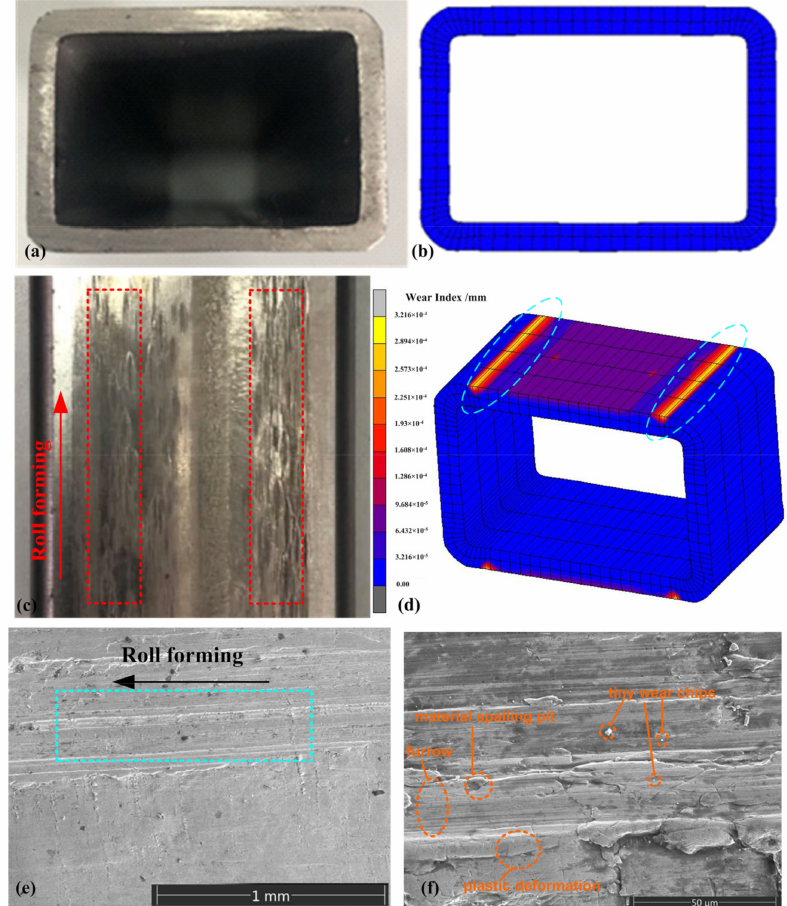
Figure 8. The test results are compared with the simulation results: ( a ) Dimension of the section forming. ( b ) Simulation of the section forming. ( c ) Wear on the surface of the rectangular tube. ( d ) wear simulation. ( e ) Scanning electron microscope (SEM) photo of the wear area. ( f ) SEM photo of the area